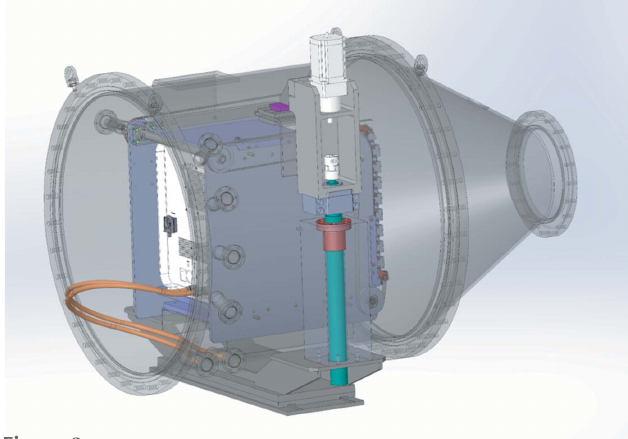
Figure 3 CAD design of the new flight tube end housing detector, ‘guillotine’ and beamstop with incorporated diode in